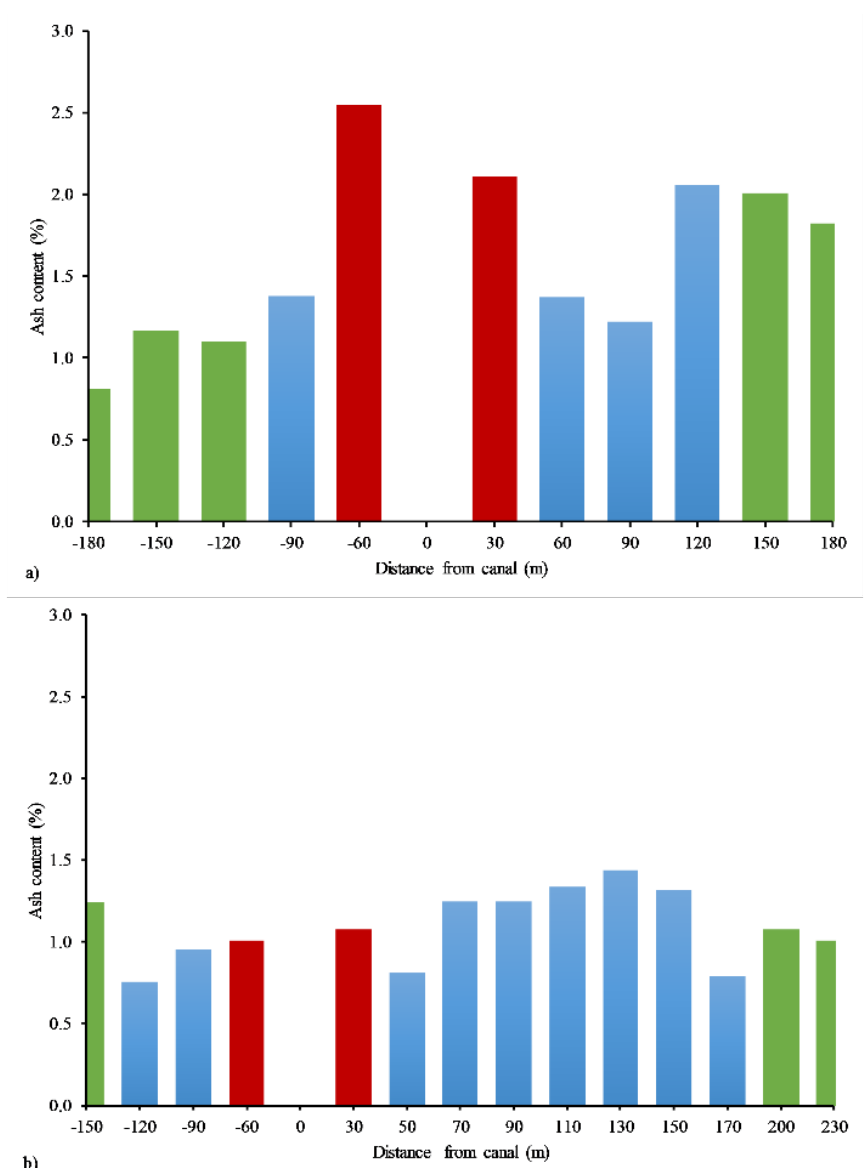
Figure 5. The spatial distribution of surface ash in (a) Transect 1 and (b) Transect 2 (green represents peat swamp forest; blue represents open peat; red represents peat nearest to the